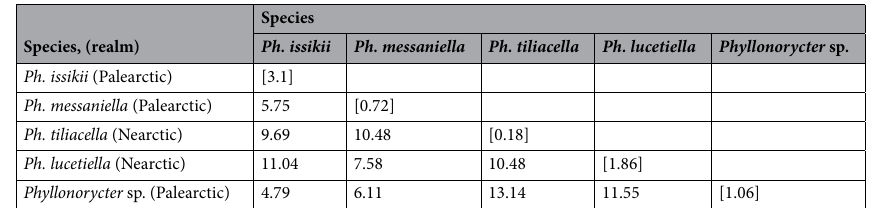
Table 2. Intra- and interspecific genetic divergences in DNA barcode fragments (COI mtDNA) in the archival specimens of lime-feeding Phyllonorycter spp. dissected from herbaria in the Palearctic and Nearctic*. *Kimura two-parameter (K2P) distances; each species pair is provided with minimal pairwise distances; values in square brackets show maximal intraspecific distances. Number of analyzed archival specimens (N): Ph. issikii (50), Ph. lucetiella (13), Ph. messaniella (2), Ph. tiliacella (2), Phyllonorycter sp. (4).